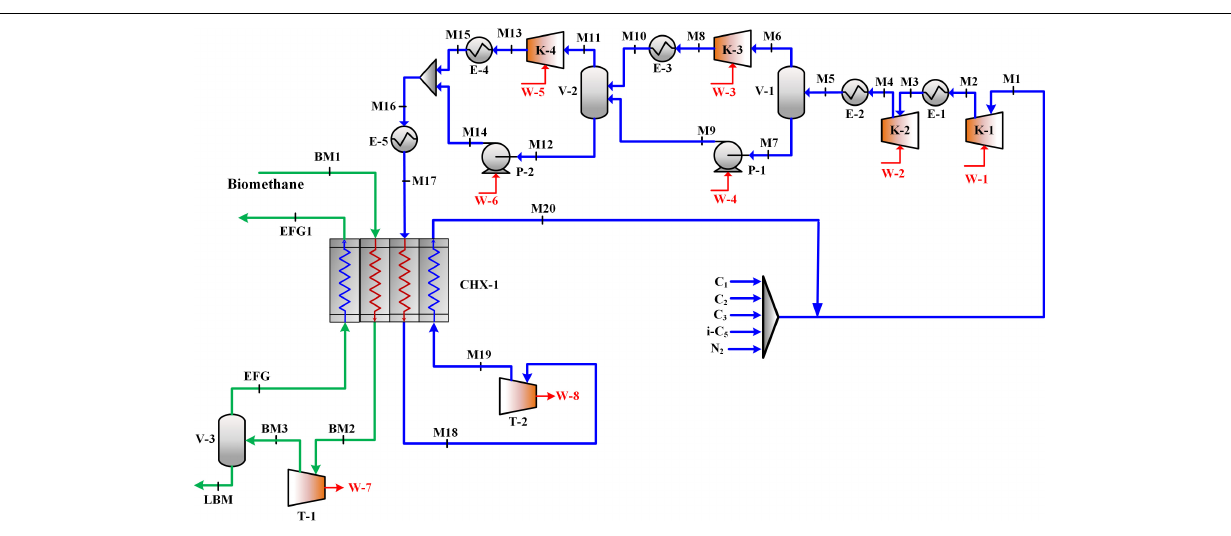
FIGURE 3 | Modified biomethane liquefaction